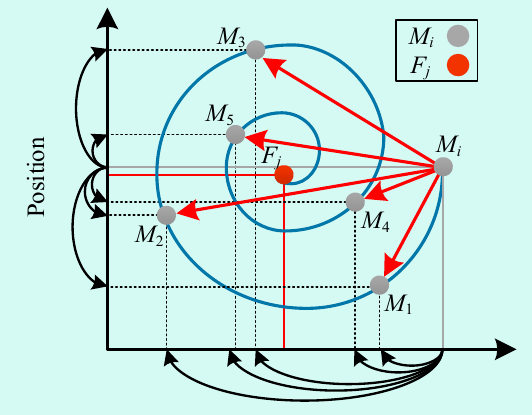
Figure 5. Position updating mechanism of moth.